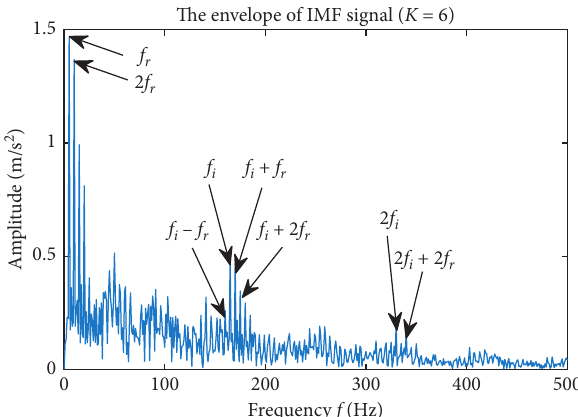
Figure 14: IMF signal envelope spectrum of inner ring using the VMD with TAGA optimization.